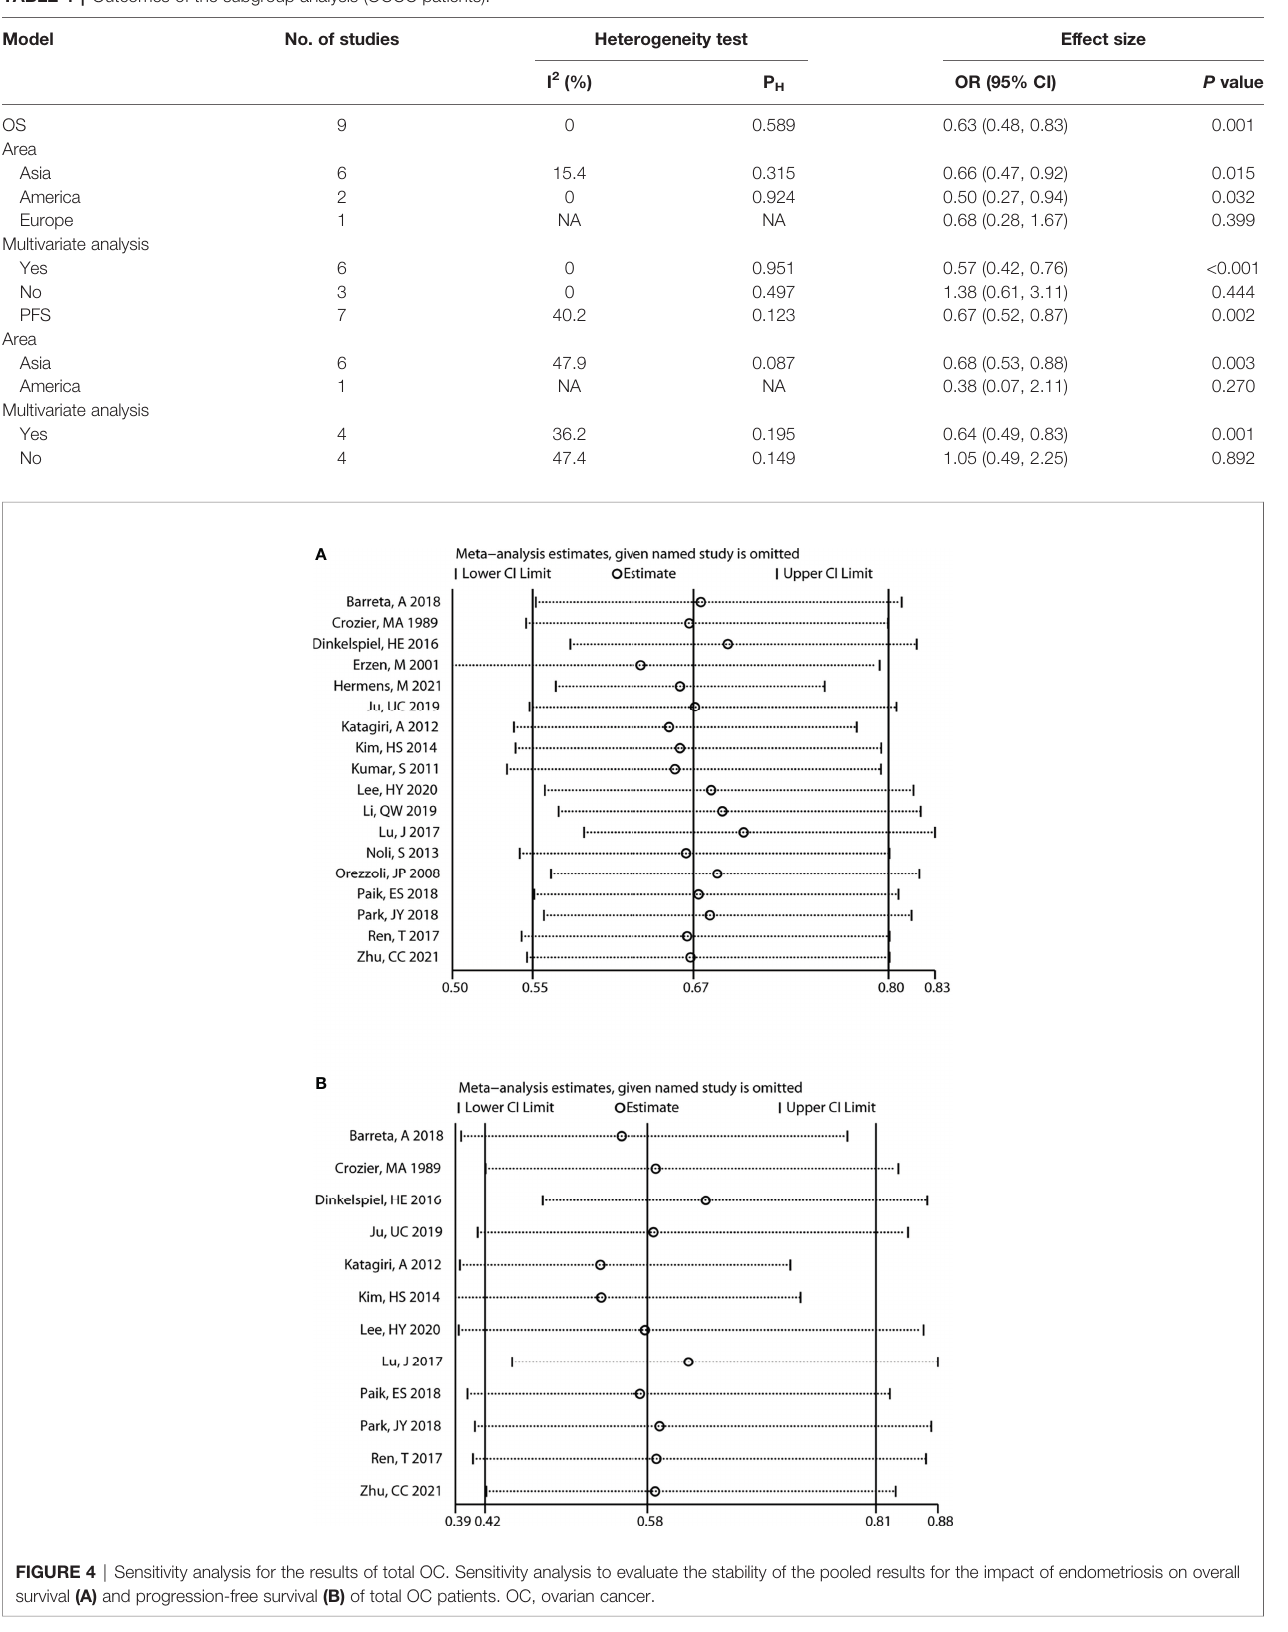
TABLE 4 | Outcomes of the subgroup analysis (OCCC patients).